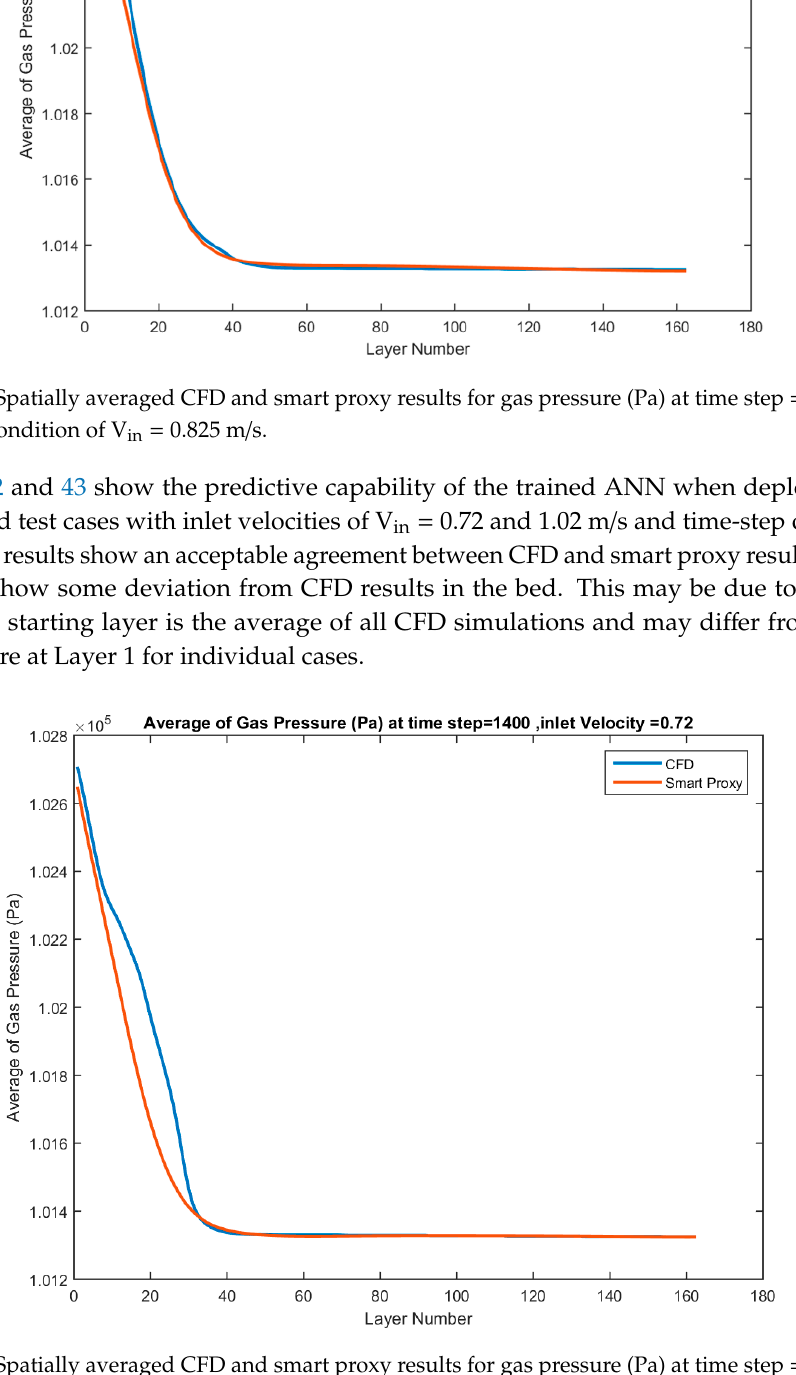
Figure 43. Spatially averaged CFD and smart proxy results for gas pressure (Pa) at time step = 1400 for blind test condition of V in = 1.02 m/s. The above results show an acceptable agreement between CFD and smart proxy results. The smart proxy results show some deviation from CFD results in the bed. This may be due to the fact that pressure at the starting layer is the average of all CFD simulations and may differ from the actual average pressure at Layer 1 for individual cases. 4.4. Time average Flow in a fluidized bed is highly transient and chaotic. As such, even multiple CFD simulations of the same flow conditions yield different instantaneous flow fields, although the time-averaged flow field must be the same. For this reason, the performance of a fluidized bed is typically assessed